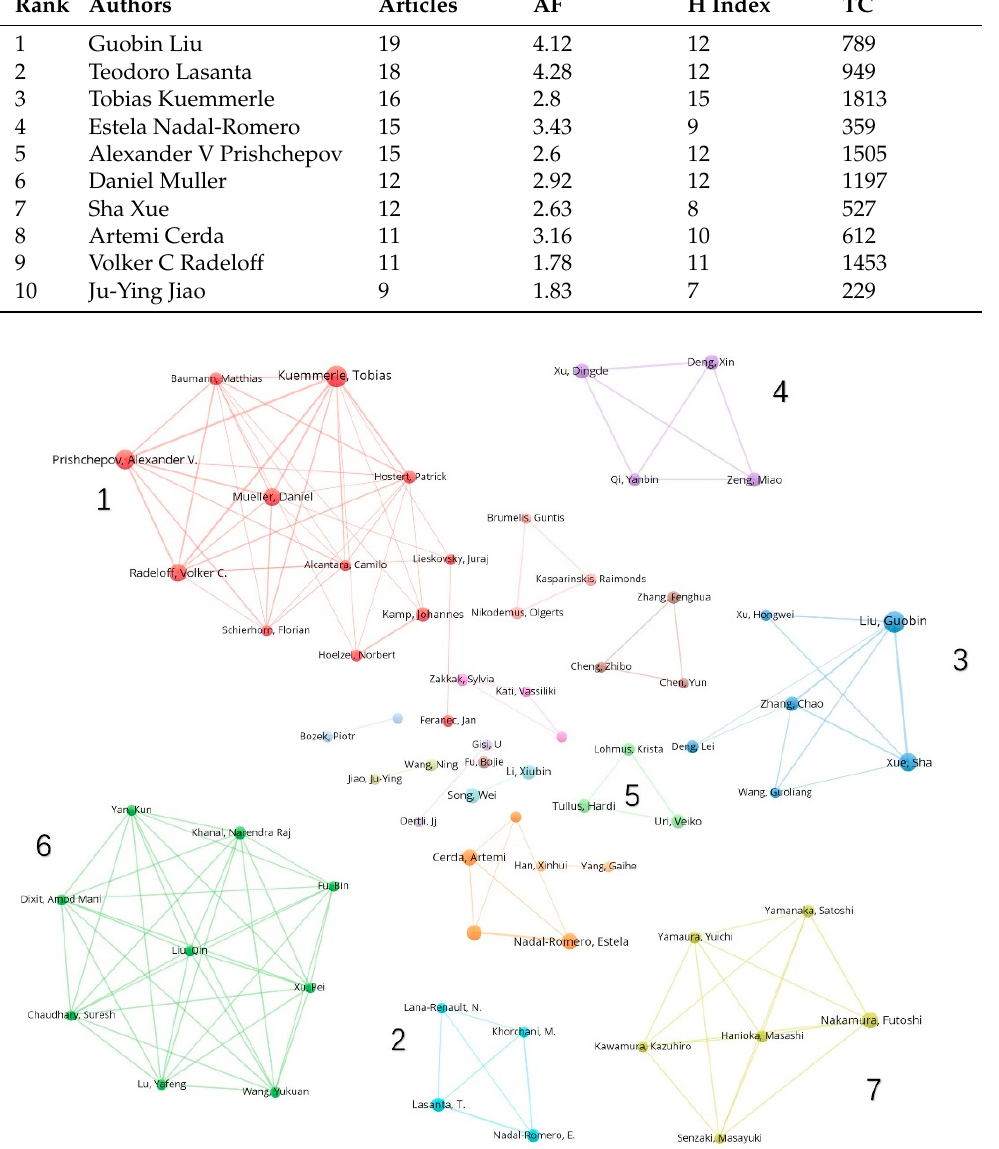
Figure 5. Collaborative network of authors publishing papers on farmland abandonment from 1980 to